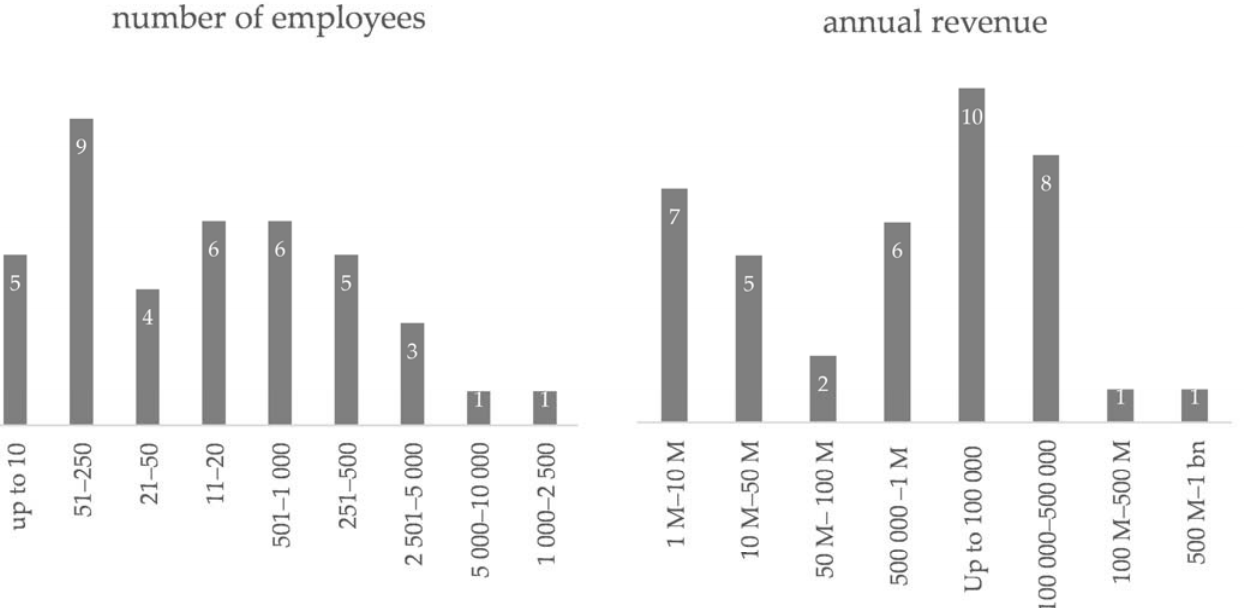
Figure 5. Organisation size by employees and annual revenue in USD.